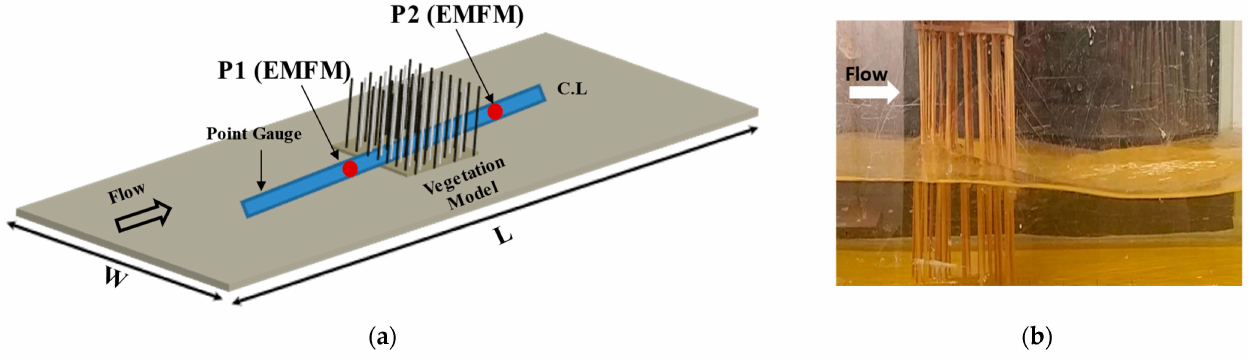
Figure 5. Model Validation ( a ) Experimental Flume setup and specific locations for measurement of water level and vertical distribution of streamwise velocity; ( b ) Resulting flow